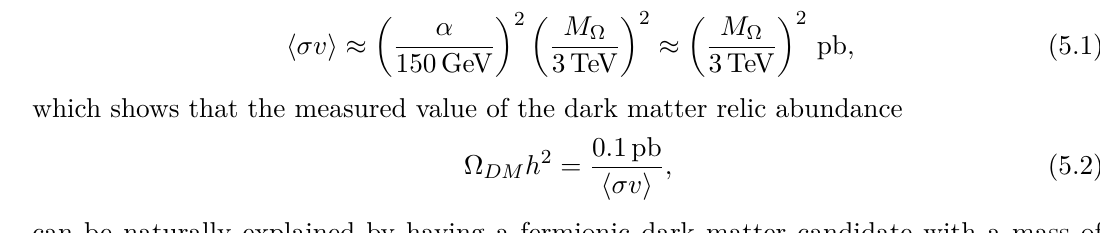
where the corresponding eff